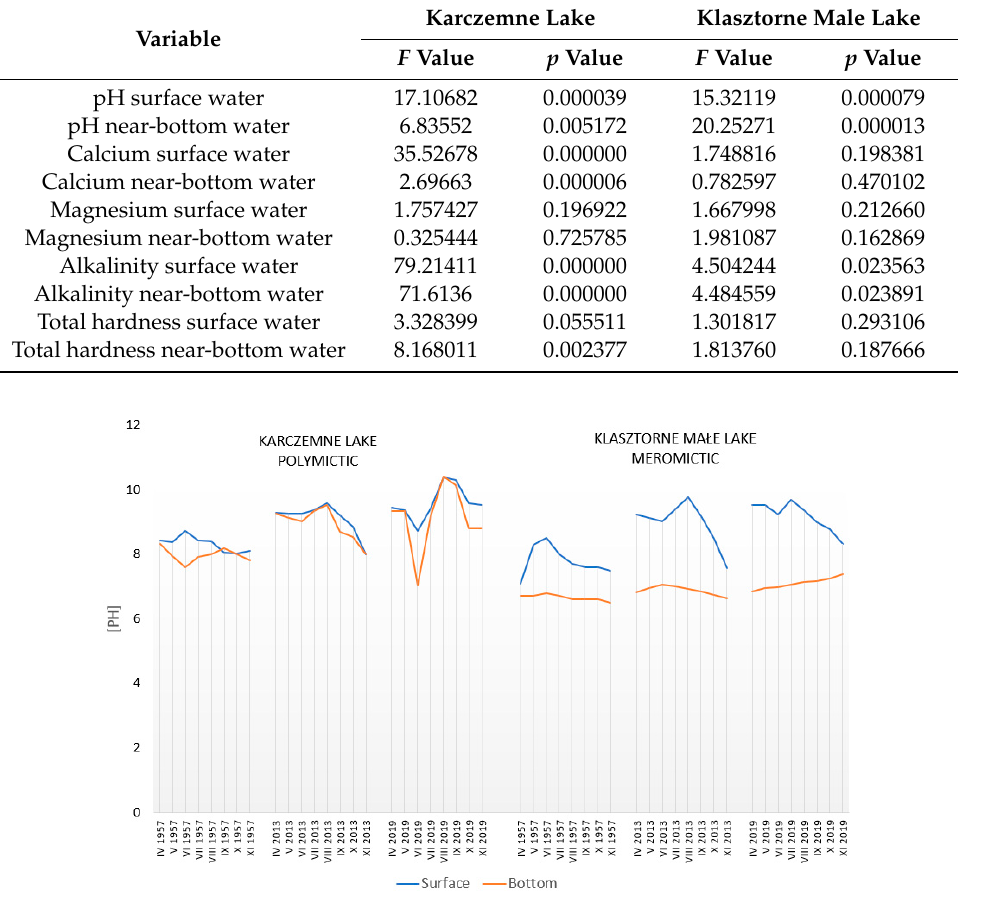
Table 2. Results of one-way ANOVA analyses for investigated variables in the water of Karczemne and Klasztorne Małe lakes.